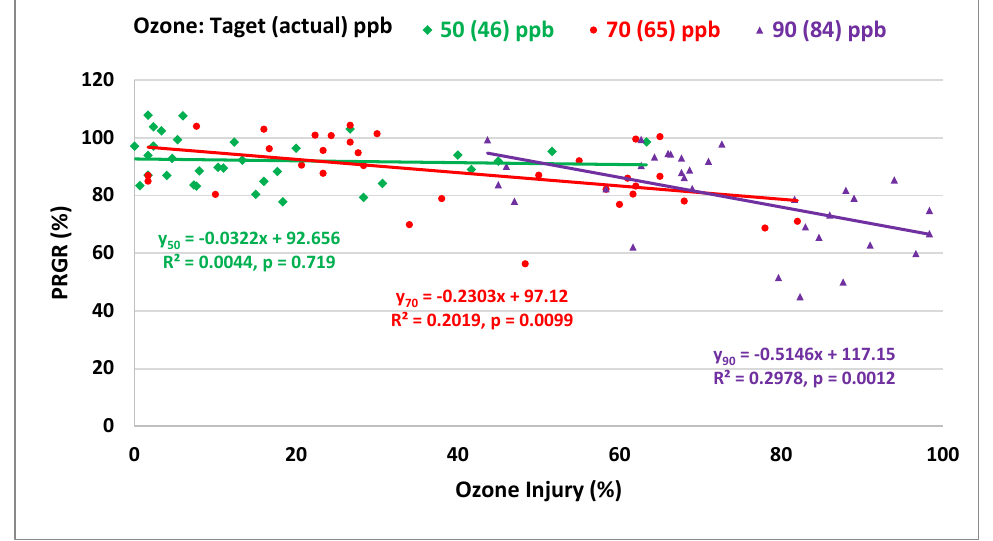
Figure 16. Relationship between percent relative growth rate (PRGR) and O 3 injury on third – fifth leaves of seven RnUS wheat genotypes at each of three different O 3 levels of 50, 70, and 90 ppb (12 h/day, at 25 °C and 50% RH, for 14 days in OPECs). PRGR is the relative growth rate of individual plants referenced to the genotype’s average RGR in charcoal -filtered air (O 3 = 5 ppb).